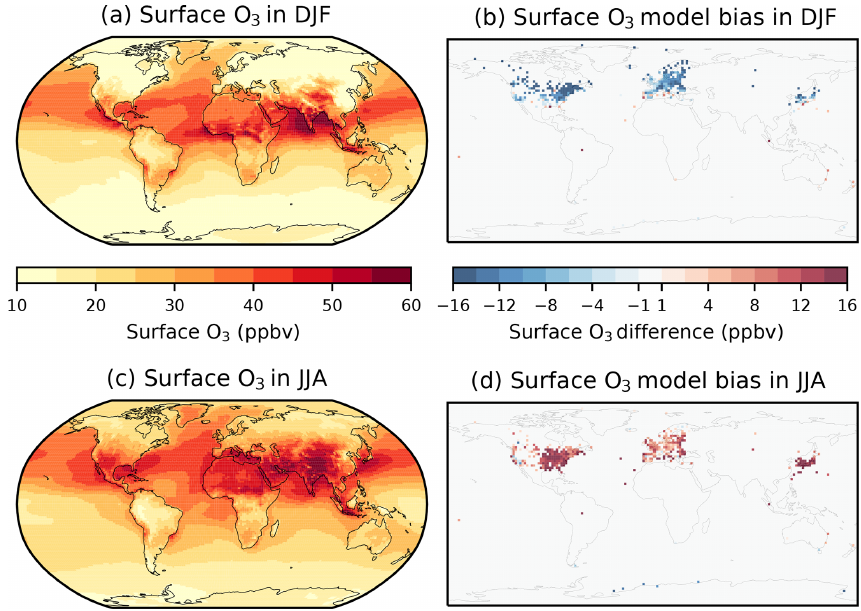
Figure 5. Simulated (ND) seasonal mean surface O 3 concentrations in (a) December–January–February (DJF) and (c) June–July–August (JJA) over the 2005–2014 period. Difference between simulated and observed surface O 3 from the gridded TOAR database in (b) DJF and (d)